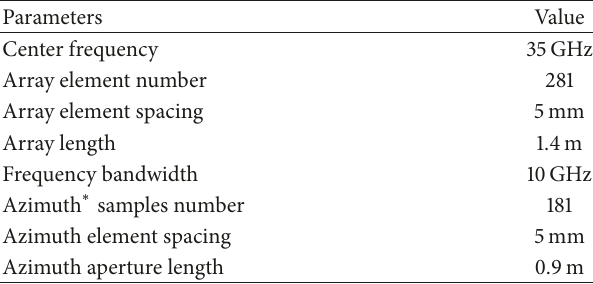
Table 3: Measurement parameters of the real data